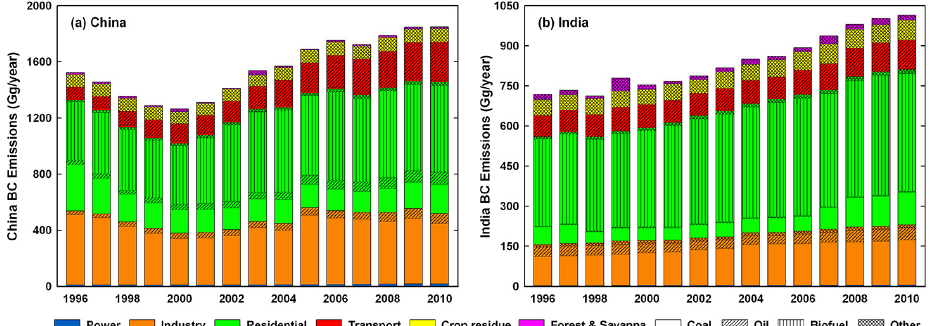
Fig. 3. BC emissions by sector and fuel type in (a) China and (b) India during